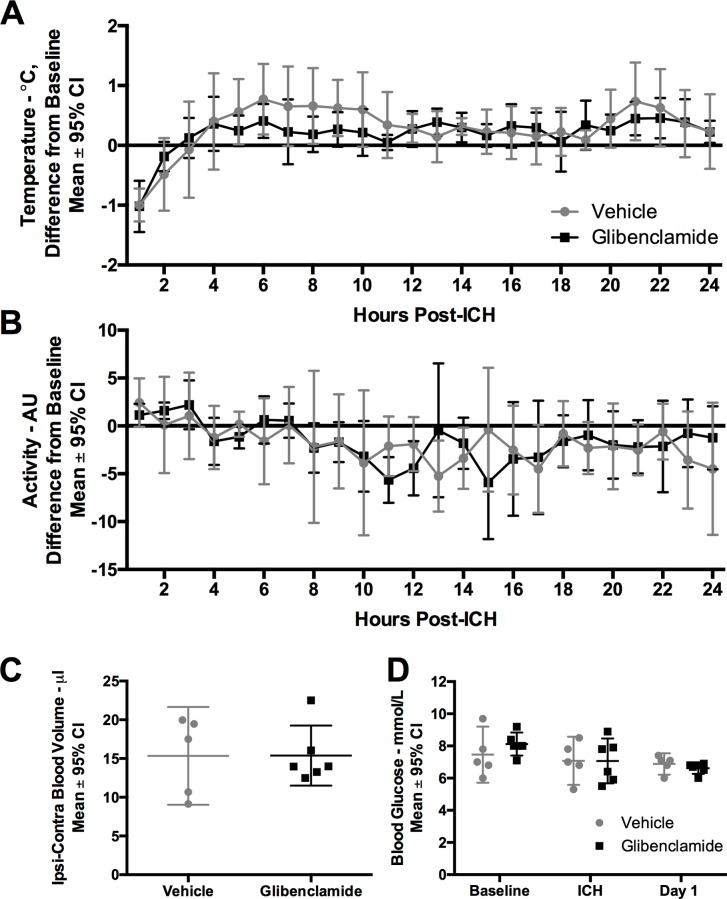
Experiment 1.Glibenclamide did not significantly impact (A) core temperature (P = 0.187, group main effect) or (B) activity (P = 0.876, group main effect) after ICH (n = 6 in glibenclamide group, n = 5 in control group). Core temperature (°C) and activity (AU, arbitrary units–detections of animal movement over a receiver [36]) data were taken using implanted telemetry devices. Core temperature and activity averages for each hour were corrected for the same hour of baseline data to account for time of day effects (e.g., circadian rhythms). Rectal temperature was regulated during surgical procedures; the core temperature drop within the first few hours was due to rapid but mild cooling after post-surgical anaesthesia. (C) Bleeding (P = 0.991) and (D) blood glucose (P = 0.763, group main effect) were both unaffected by glibenclamide. Sample sizes were n = 6 in glibenclamide group, n = 5 in control group.